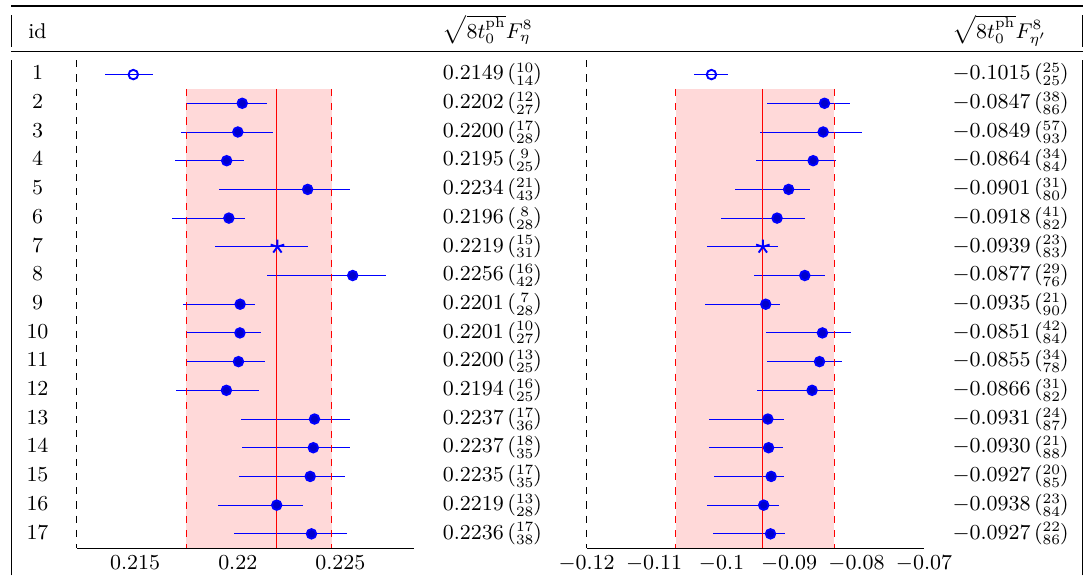
Table 11. Octet decay constants of the η and η 0 at the physical point in units of the gradient flow scale, displayed as in table